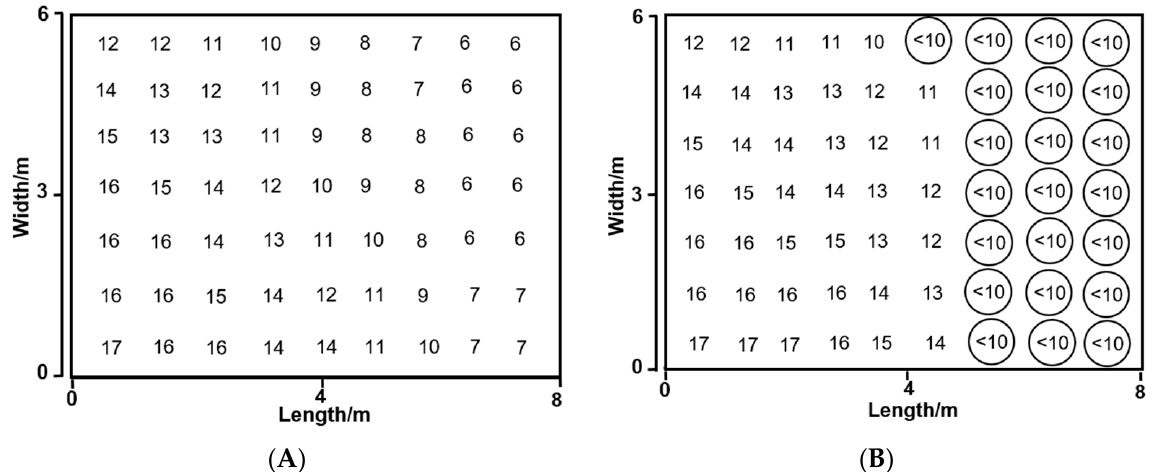
Figure 10. Pseudo-color graph of room space illuminance distribution.